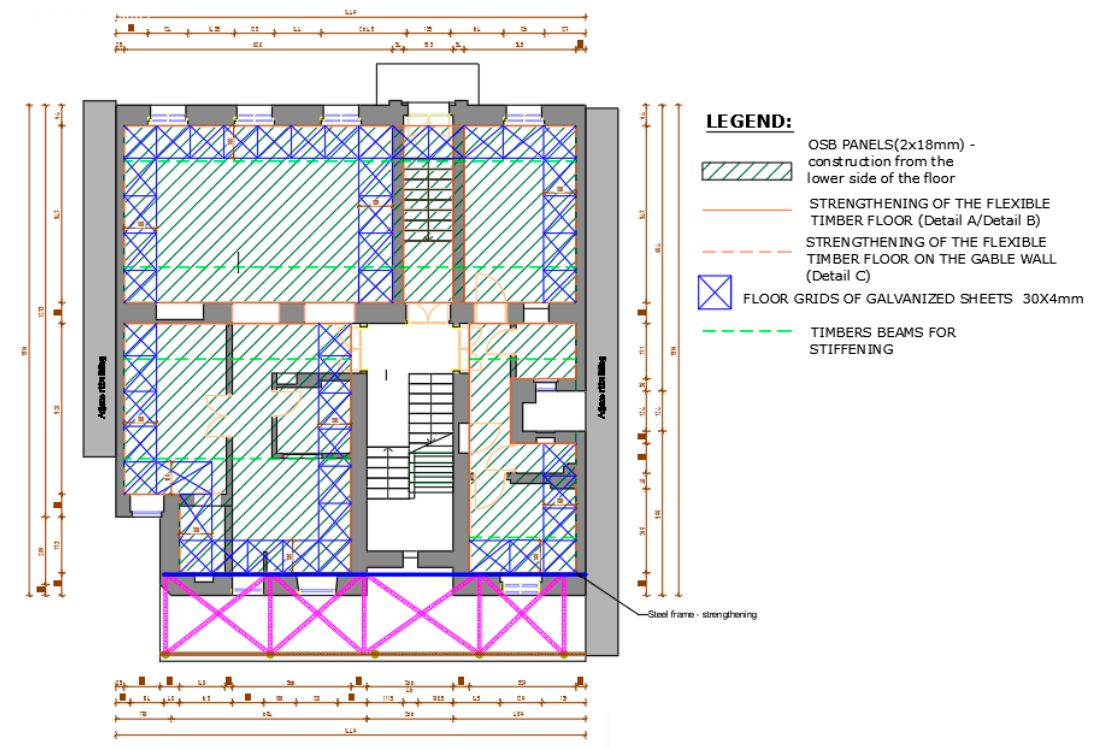
Figure 18. Strengthening measures of the floor at the ground floor level.